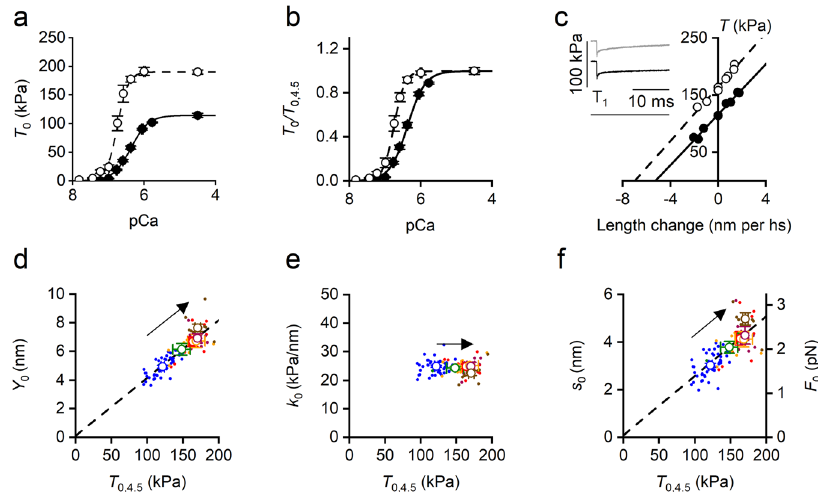
Fig. 2 Effect of temperature on the relevant mechanical parameters of Ca 2 + -activated skinned soleus fi bre. a Force-pCa relations interpolated with the Hill equation (see SI Methods). Filled circles and continuous line, 12 °C; open circles and dashed line, 35 °C. T 0 in absolute units (kPa). b As in a with T 0 relative to T 0 at pCa 4.5 ( T 0,4.5 ). c T 1 relations at 12 °C ( fi lled symbols) and 35 °C (open symbols) at pCa 4.5. Lines are fi rst order regression equations fi tted to the data at 12 °C (continuous) and 35 °C (dashed). In the inset sample records of the force response to the small step release are superimposed to show the force attained at the end of the step ( T 1 ). From top to bottom force at 35 °C, at 12 °C and force baseline. d Dependence on temperature -modulated T 0,4.5 of Y 0 (half-sarcomere strain) and fi t of pooled data with a fi rst order regression equation (dashed line, slope 0.040± 0.003nm/kPa, ordinate intercept 0.10 ± 0.38 nm). e Dependence on T 0,4.5 of k 0 (half-sarcomere stiffness). f Left ordinate: dependence on T 0,4.5 of s 0 (motor strain) and linear fi t of pooled data (dashed line, slope 0.025± 0.003 nm/kPa and ordinate intercept 0.08 ± 0.37 nm). Right ordinate: dependence on T 0,4.5 of F 0 (motor force). The corresponding parameters of the linear fi t are 0.014 ± 0.001 pN/kPa (slope) and 0.04 ± 0.20 pN (ordinate intercept). In d and f the slopes are signi fi cantly different from zero ( P always <0.005) and the ordinate intercepts are not signi fi cantly different from zero ( P always >0.75). The arrows in panels d – f indicate the direction of the rise in temperature from 12 to 35 °C; the colours refer to different temperatures: 12 °C, blue; 17 °C, green; 20 °C, red; 25 °C, orange; 30 °C, purple; 35 °C, brown. In a and b , data are mean values (± SEM) from 5 fi bres. In c data from one fi bre: fi bre length, 3.23 mm; length of the segment under the striation follower, 0.72 mm; average sarcomere length, 2.30 μ m; CSA, 4210 μ m 2 . In d – f , fi lled circles are pooled data and open circles the mean values (± SEM) from 31 fi